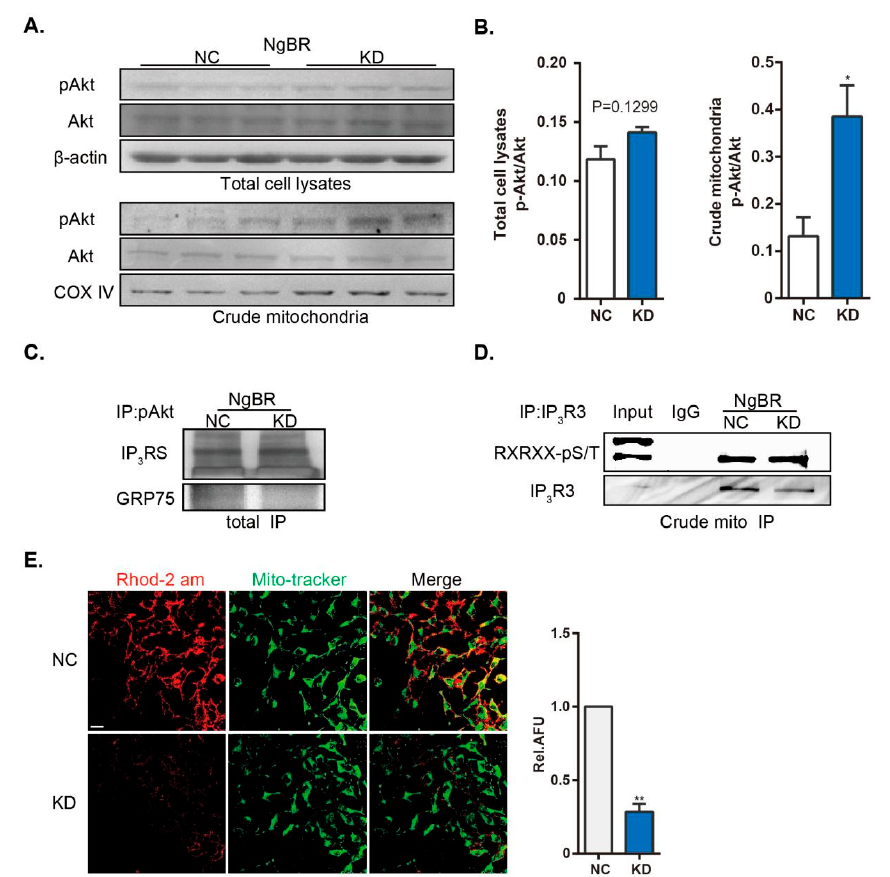
Figure 4. Downregulation of NgBR enhances pAkt signaling at the MAM surface and reduces Ca 2 + m . The phosphorylation of Akt (Ser473) and total Akt level were detected in ( A , B ) total cell lysates and crude mitochondrial extracts. n = 3. ( C ) IP of pAkt was performed from a total cell homogenate, and MAM-localized proteins (IP 3 Rs and GRP75) were detected. ( D ) Phosphorylation of endogenous IP 3 R3 (Akt substrate) was detected in the immunoprecipitates of IP 3 R3 from crude mitochondrial extracts. ( E ) Representative confocal microscopy images showing co-staining of Rhod-2 AM (red) and MitoTracker Green (green). Results were calculated as relative AFU using ImageJ. n > 20 pictures / group from three independent experiments. Scale bar = 20 µ m. * p < 0.05, ** p <